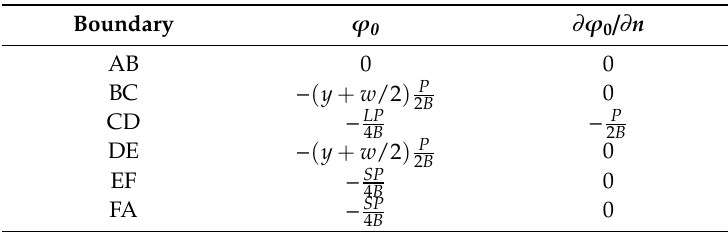
Table 4. The boundary conditions.